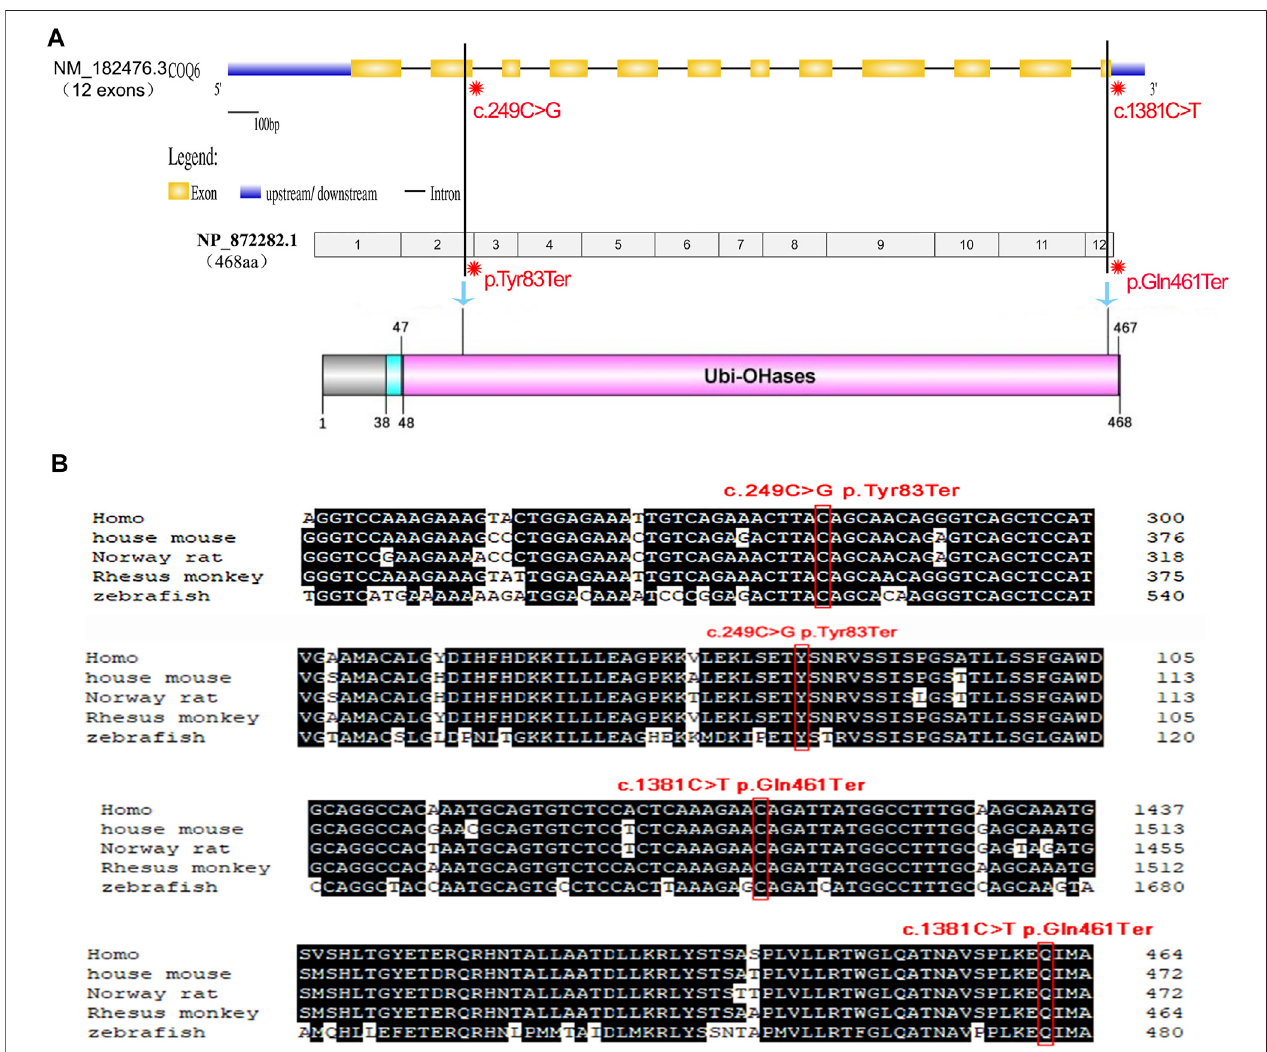
FIGURE 3 | Schematic of the gene structure and domain structure of COQ6 protein and conservation analysis of the two nonsense mutations detected in the family. (A) The COQ6 genecontaining12exons(yellowboxes)wasexhibitedusingtheUDSDonlinedatabase,andthelocationofthetwovariantsistaggedinthe COQ6 exonregionanditscorrespondingUbi-OHasesdomain. (B) ComparativeanalysisofgenomesequencesorCDSsacrossspeciesindicatesthatthetwomutantsitesare evolutionarily highly